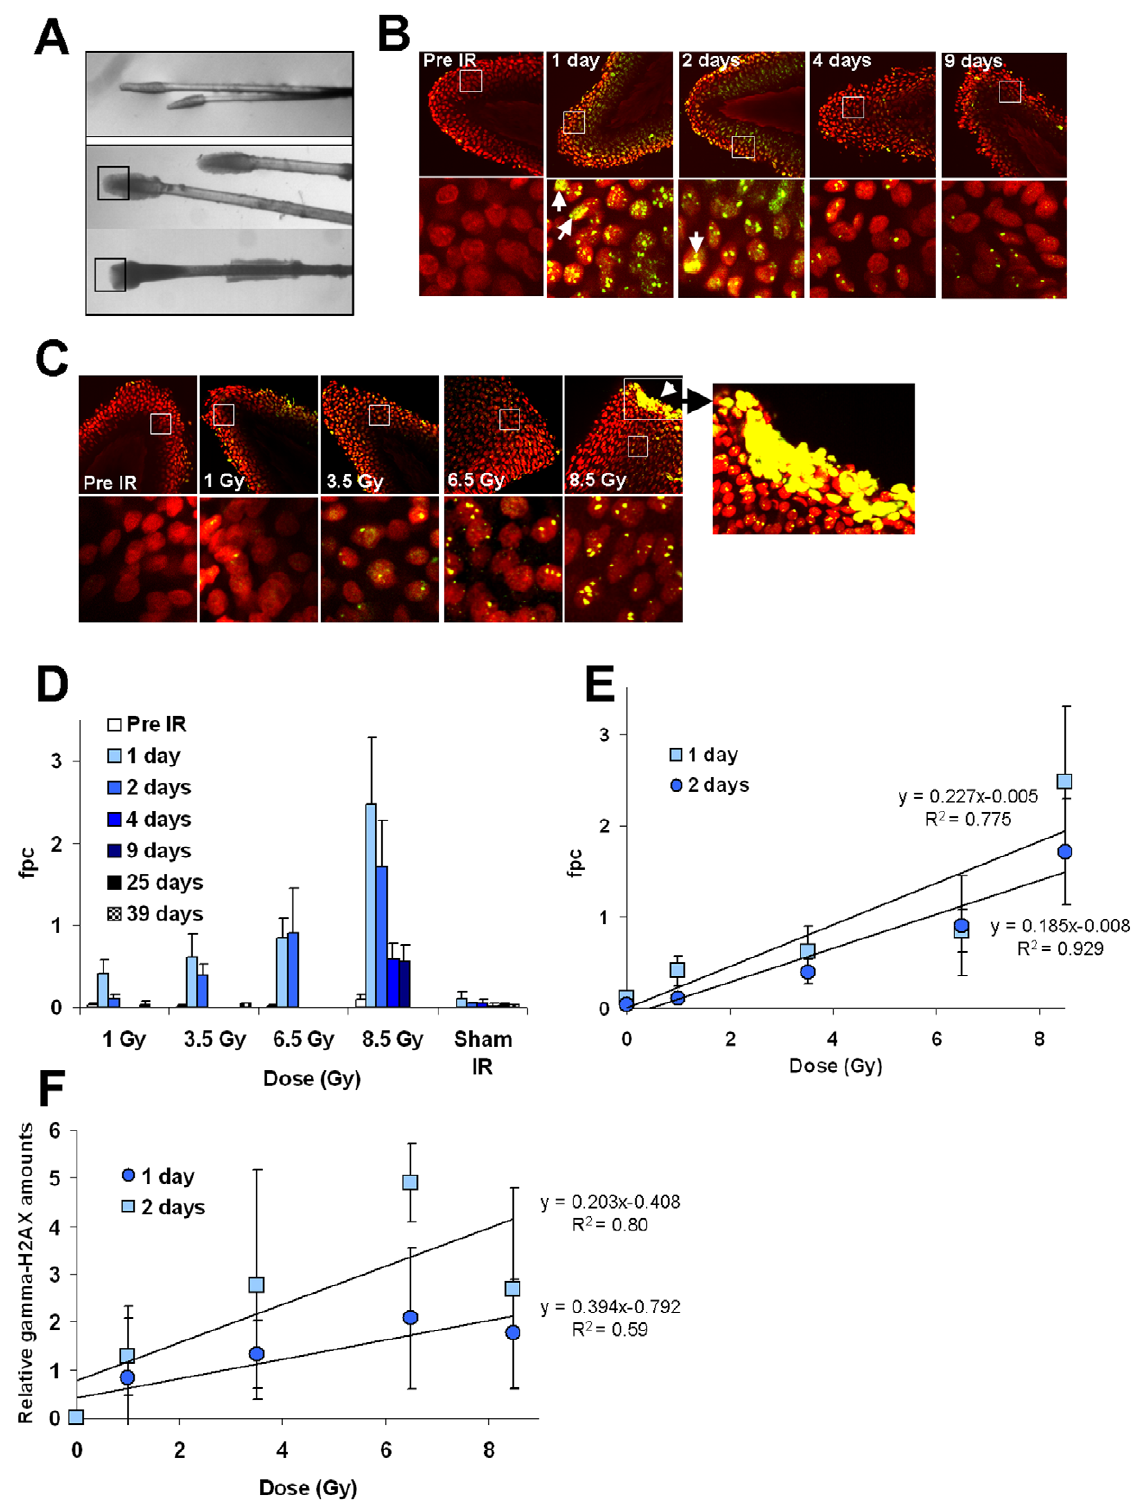
Figure 3. Kinetics for c -H2AX foci in macaque plucked hairs after total-body irradiation. ( A ) Representatives images of plucked hairs obtained from the fur and the head (upper panel) and from eyebrows and whiskers obtained from the face (lower panels). Plucked eyebrow hairs and whiskers with morphologies similar to the ones shown in the lower panels were found suitable for c -H2AX detection. The black squares in the lower panel indicate the region of interest for c -H2AX microscopy. ( B and C ) Representative images of sampled hair bulb regions of eyebrow hairs and whiskers taken from NHPs at the indicated times after 8.5 Gy-TBI ( B ) and at 1 day after the indicated TBI doses ( C ) are shown. Images in the bottom row are enlargements of the regions inside the white squares in the upper images. The rightmost image in ( C ) is an enlargement of the apoptotic region in the adjacent image. Arrows denote apoptotic cells in the other images. Green, c -H2AX; red, DNA stained with PI. ( D ) Kinetics for c -H2AX foci